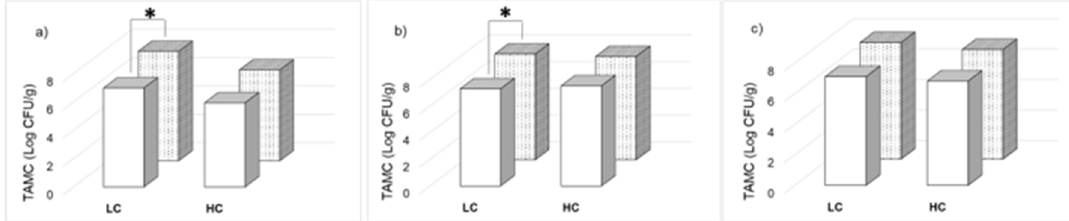
Figure 2. Ready-to-eat salad average total aerobic mesophilic count (TAMC) contamination levels at packaging date ( □ ) and after 2 days of storage of the opened bags at 4 °C ( ) for low-cost (LC) and high-cost (HC) samples: ( a ) baby romaine lettuce (BRL); ( b ) rocket salad (RS); ( c ) lamb’s lettuce (LL) samples (SD < 10%) evaluated using the plate count method * Significant difference ( p < 0.05) . Table 4. Ready-to-eat leafy green salad average total aerobic mesophilic count (TAMC) percent increase in growth after package opening during a simulated home-refrigeration of 2 days at 4 °C for each variety and cost category. opened bags at 4 °C was observed only for LC, BRL and RS samples; no significant difference was